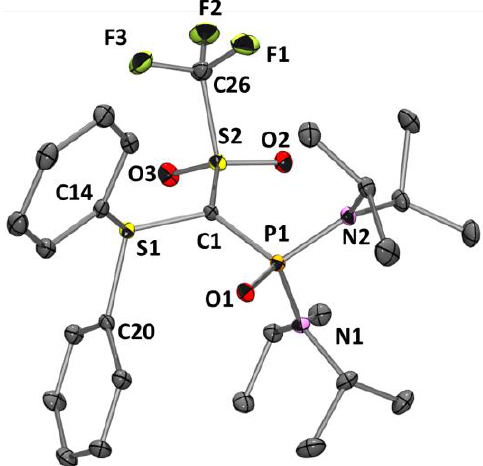
Figure 4. Molecular structure of 7 . Ellipsoids are drawn at the 30% probability level; hydrogen atoms are omitted for clarity. Selected bond lengths (Å) and angles (°): S1–C1 1.724(2), C1–S2 1.694(2), C1–